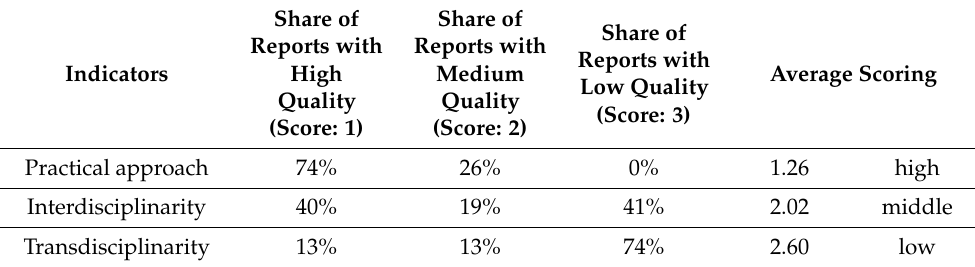
Table 3. This table shows the assigned scores of the 3 indicators in class B based on the qualitative assessment of 53 student